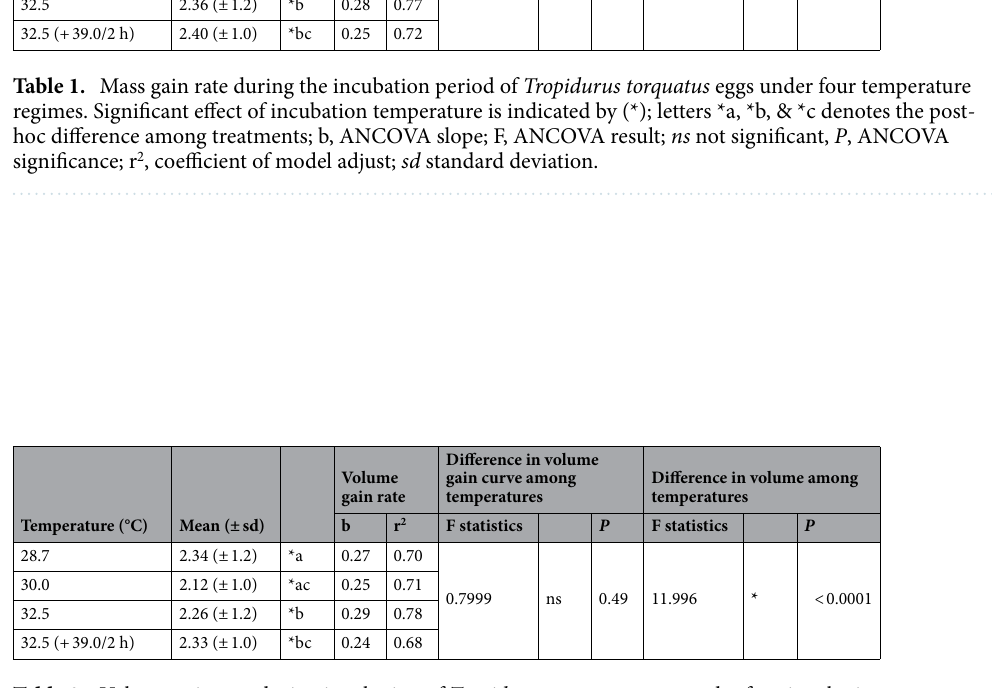
Table 2. Volume gain rate during incubation of Tropidurus torquatus eggs under four incubation temperature regimes. Significant effect of incubation temperature is indicated by (*); letters *a, *b, & *c denotes the